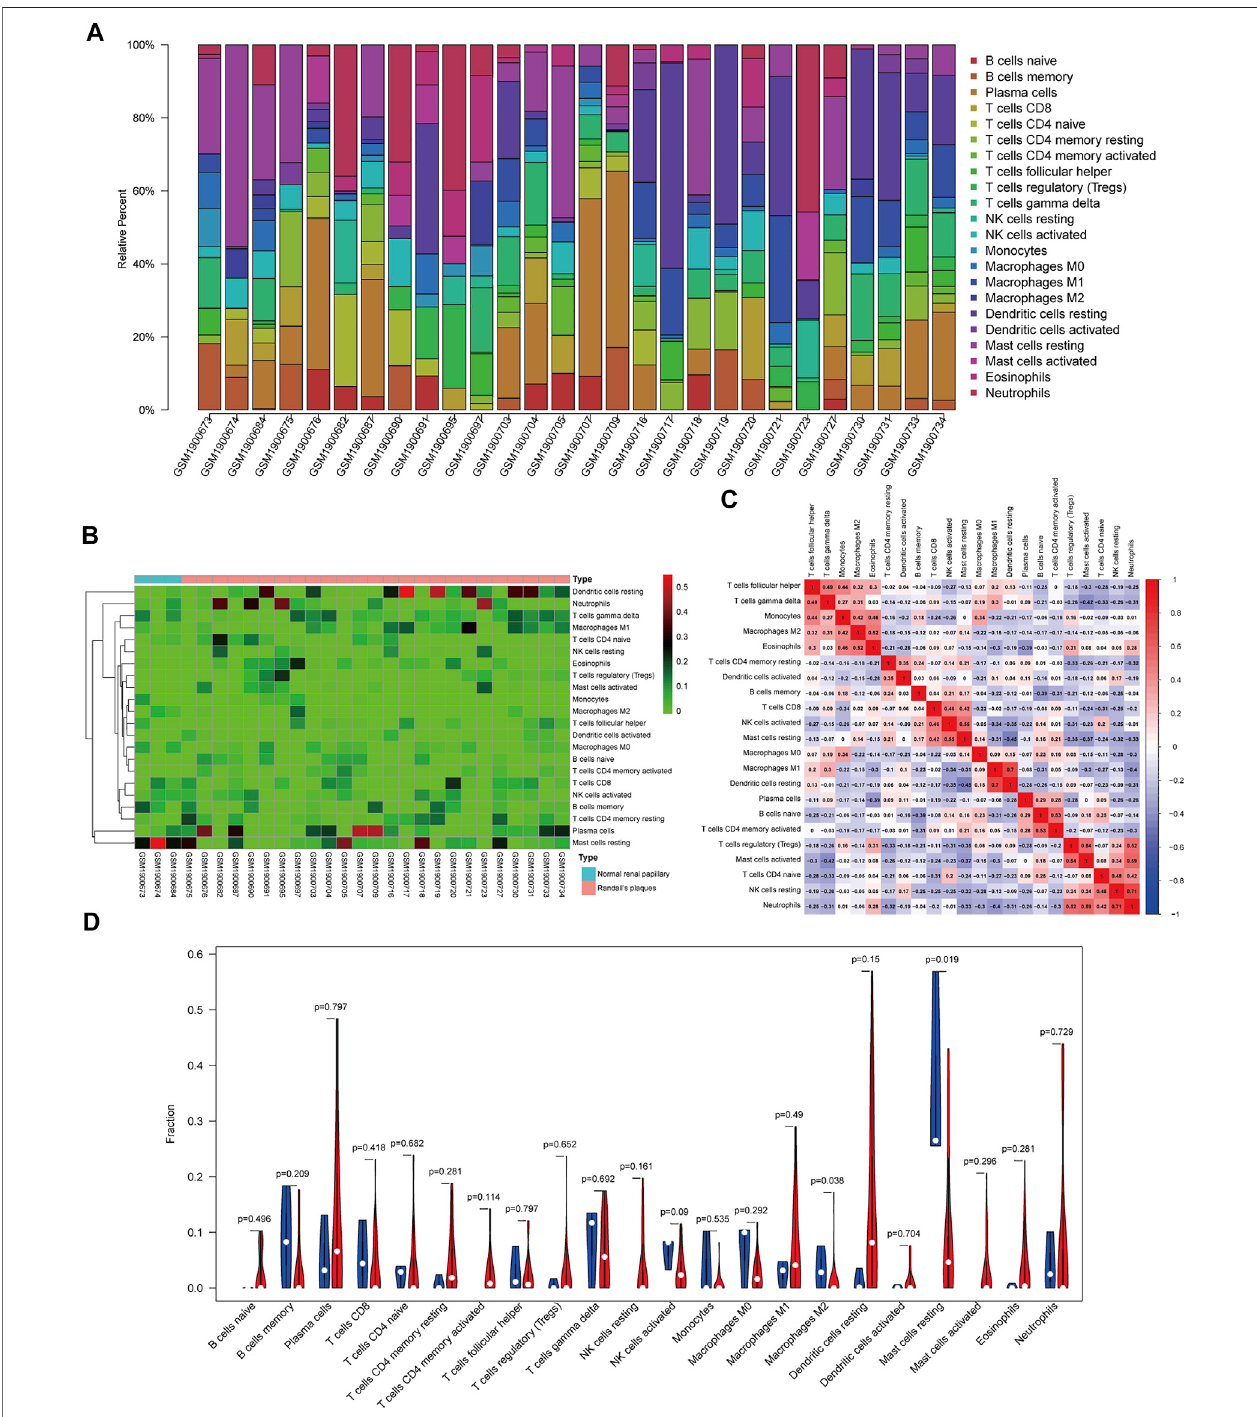
FIGURE 5 | Composition of in fi ltrating immune cells assessed using the CIBERSORT algorithm in kidney tissues. (A) Distribution of immune cell in fi ltration in each sample. (B) Heatmap of immune cell types. (C) The correlation among in fi ltrating immune cells. (D) Violin plot of in fi ltrating immune cells.